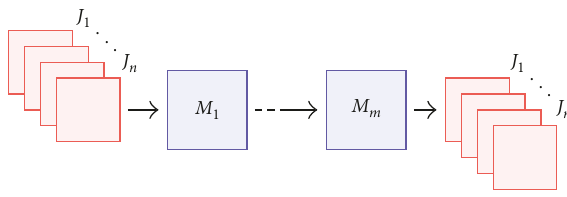
Figure 1: Flow shop problem with n jobs and m